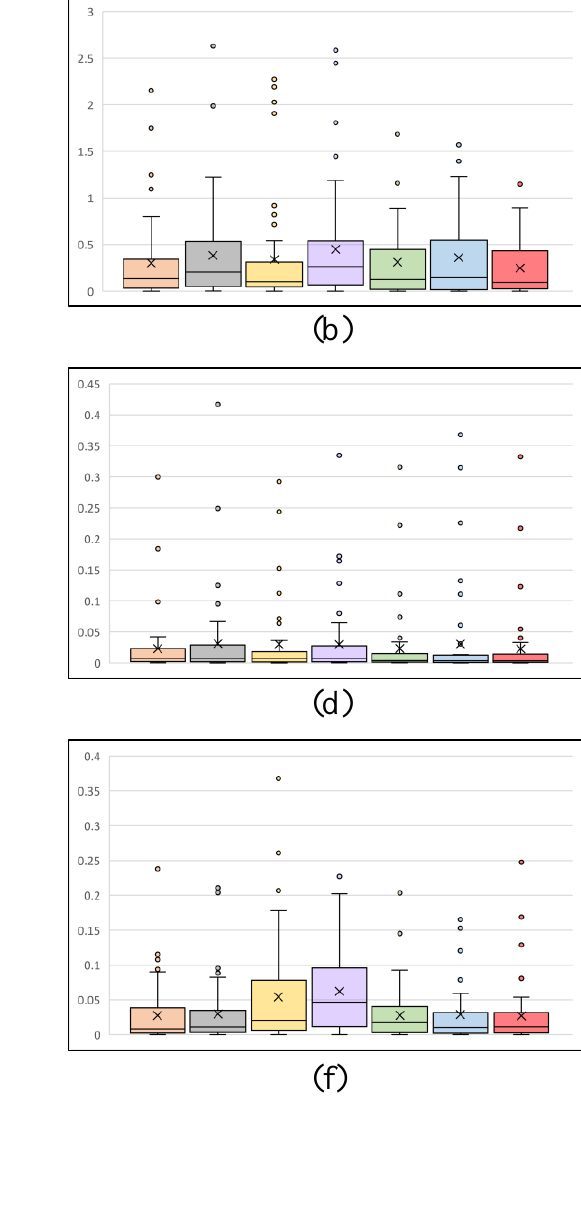
Figure 6. Scatter plots of power generation forecasts (48-month forecasts) for the period from 1 Jan- uary 2017 to 31 December 2020, when different methods were used: forecasts of ( a ) coal power, ( b ) LNG power, ( c ) oil power, ( d ) conventional hydropower, ( e ) solar photovoltaic power, ( f ) wind power, ( g ) nuclear power, and ( h ) pumped hydropower.